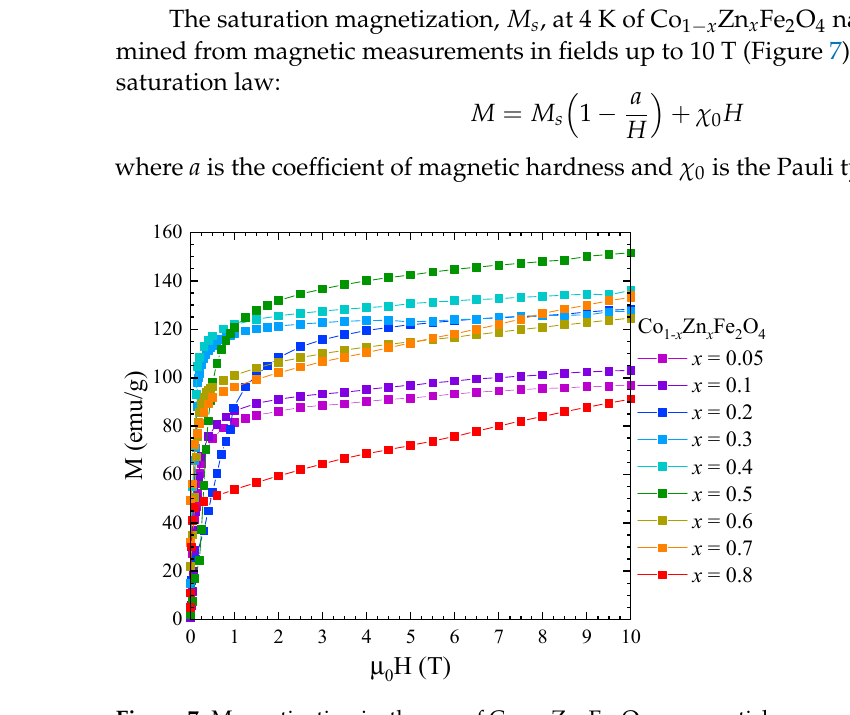
1 − x Zn x Fe 2 O 4 nanoparticles.